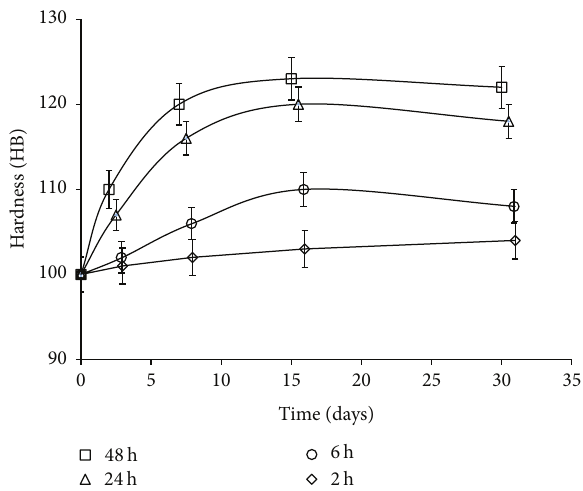
Figure 4: Evolution of hardness to the natural aging of the new alloy Al4.8 wt% Cu solution heat treatment under different